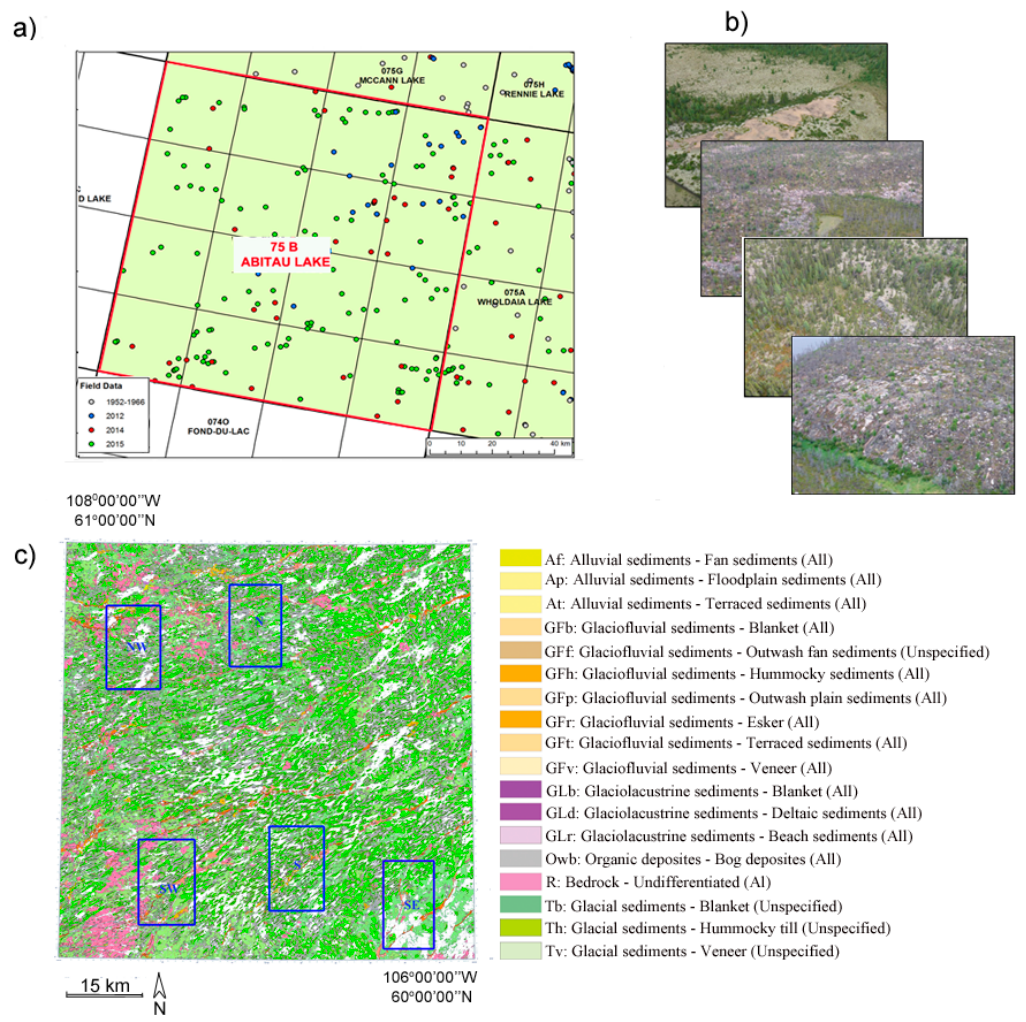
Figure 5. Surficial materials reference data sets: ( a ) ground truth; ( b ) aerial photographs from helicopter; and ( c ) surficial geology map [34].